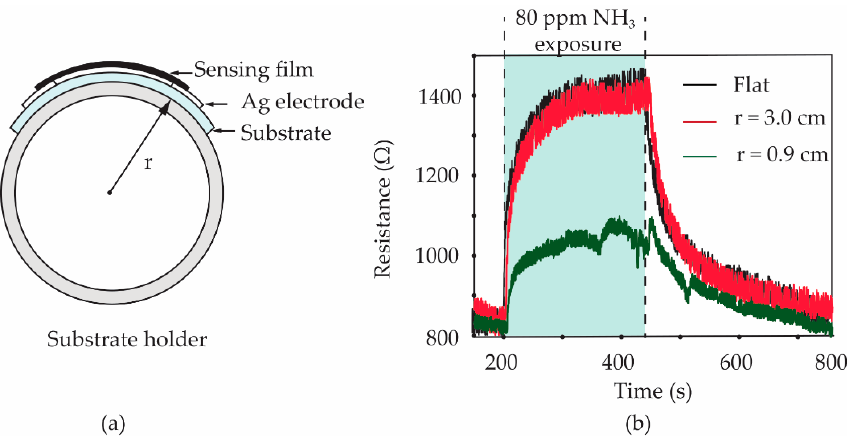
Figure 11. ( a ) Schematic diagram of f -MWCNT-PEDOT:PSS gas sensor under bending test. ( b ) Resistance changes of S3 gas sensor measured during flat and bending (r = 0.9 cm, r = 3.0 cm) states.